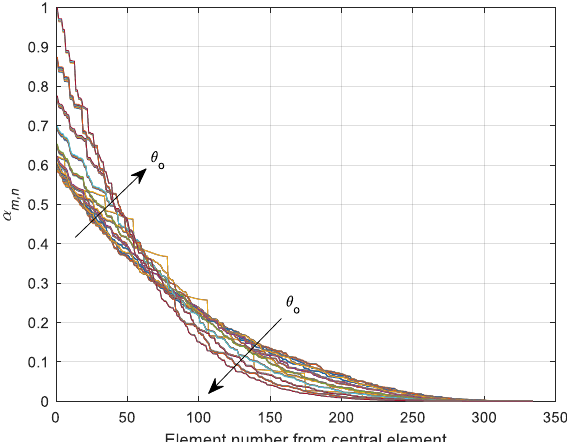
Figure 8. Variation of the array amplitude coefficients with the mainlobe direction. The arrows refer to the curves at higher values of 𝜃 𝑜 .